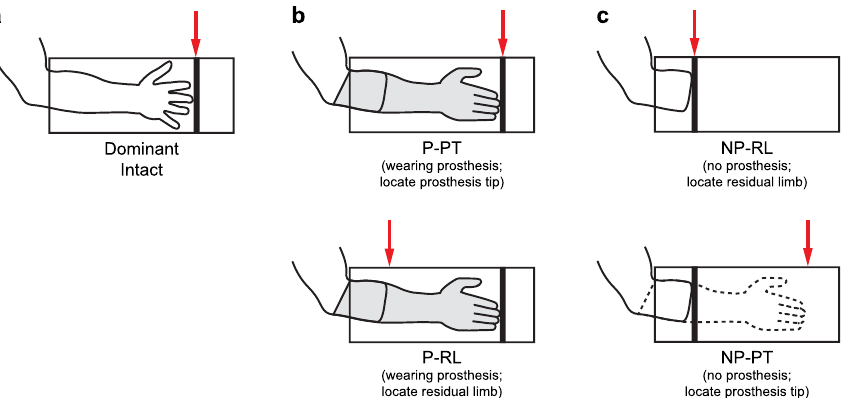
Figure 1. Conditions for the limb length estimation task. Participants performed the limb length estimation task by placing their arm inside an opaque tube with a sliding indicator affixed to the exterior. They performed this task using their dominant or intact limbs ( a ), their prosthetic limb ( b ), and their residual limb ( c ). For each condition, they estimated (red arrows) where they perceived the end of their hand, prosthesis (P-PT), residual limb (P-RL, NP-RL), or where the prosthesis would be if they were wearing it